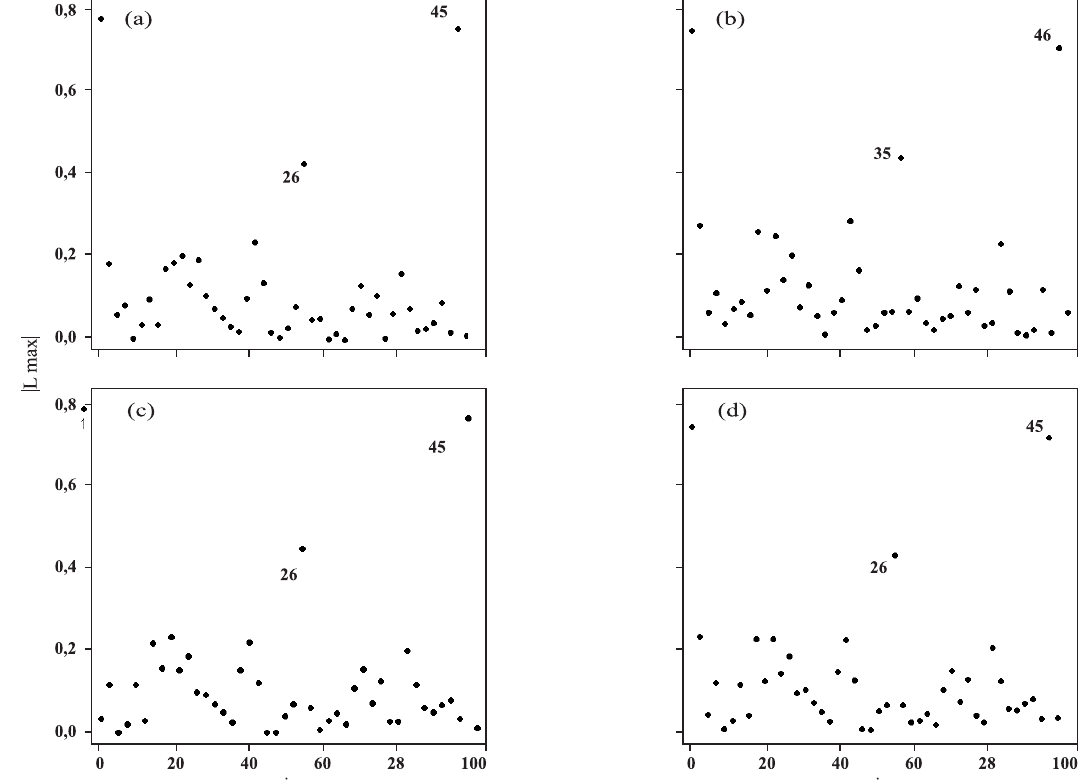
sampleFigure 9. Index plot of |L | for real data using the exponential (a), Gaussian (b), Matérn- k = 0.7 (c) and max Matérn - k = 3.0 (d) covariance Table 2. Descriptive statistics for phosphorus content [mg dm -3 ] with all observations (P) and without the observations 1, 26 and 45 (P-1-26-45)